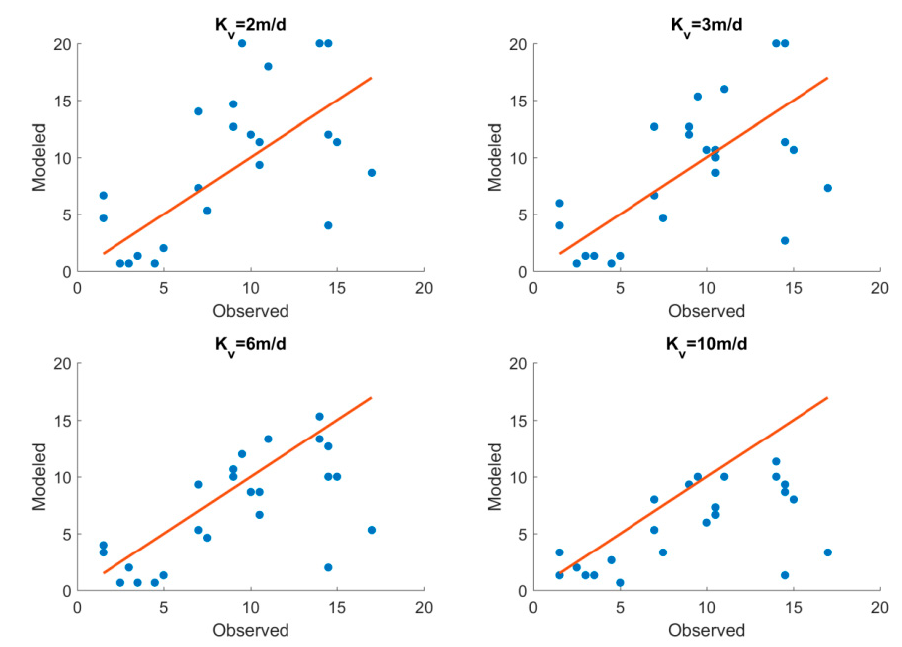
Figure 5. Observed vs. simulated lens thickness at the monitoring well locations shown in Figure 1, for four values of vertical hydraulic conductivity (Kv), with the red 1:1 line indicating a perfect match. Note that a small change in Kv results in significant changes in lens thickness.